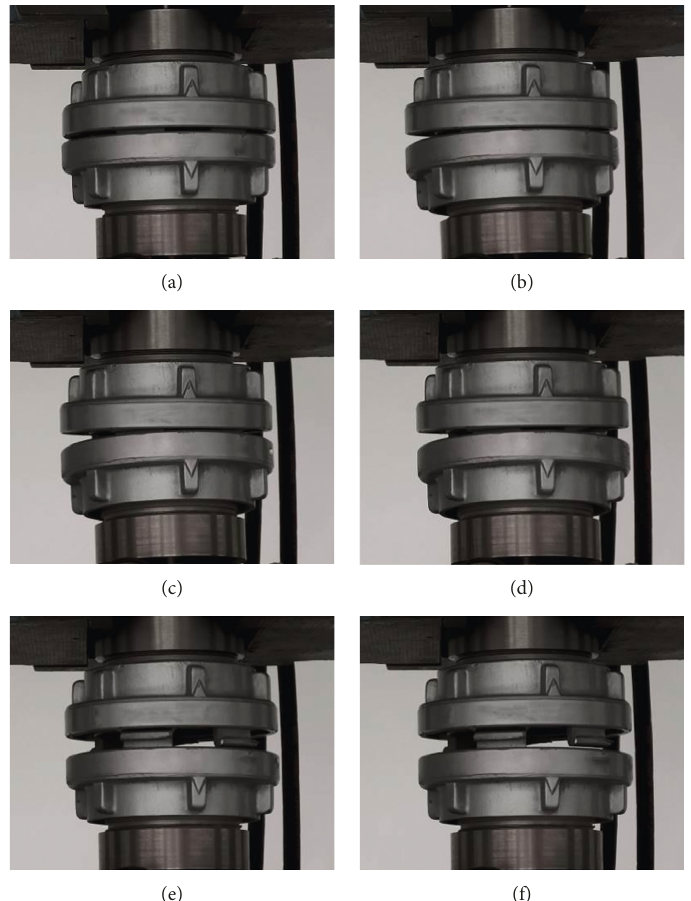
Figure 33: Joint failure process: (a) F